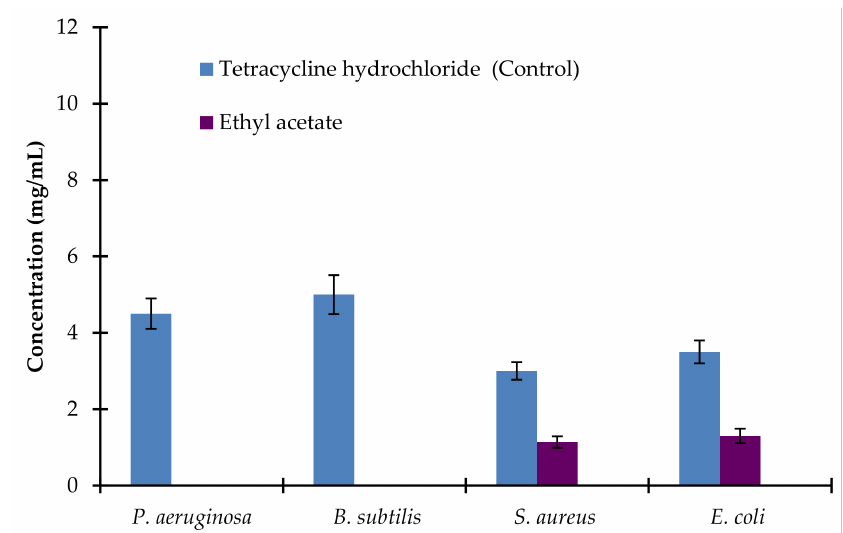
Figure 2. MIC values for ethyl acetate Avicennia marina leaf extract against P. aeruginosa, B. subtilis, S. aureus, and E. coli . Tetracycline hydrochloride was a positive control. Aqueous, chloroform, ethanol, and petroleum ether extracts did not affect any of the tested bacterial strains. Ethyl acetate extract did not affect P. aeruginosa and B. subtilis . Values are the mean of five replicates ( n = 5). Vertical bars show standard error.